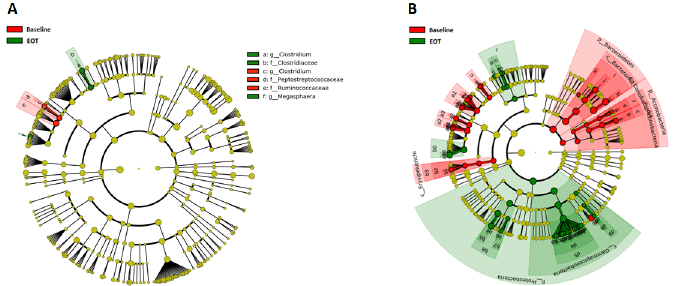
Fig 4. Effects of vancomycin and ridinilazole on relative abundance of taxa at baseline vs end-of-therapy. Cladograms were generated by LEfSe showing taxa with significantly higher relative abundance at baseline in red, and those with significantly higher relative abundance at end-of-therapy (EOT) in green. The phylogenetic tree is represented by concentric rings with phyla located at the innermost ring and subsequent taxonomic levels descend outwards to the species level. Panel A: Ridinilazole; Panel B: Vancomycin.